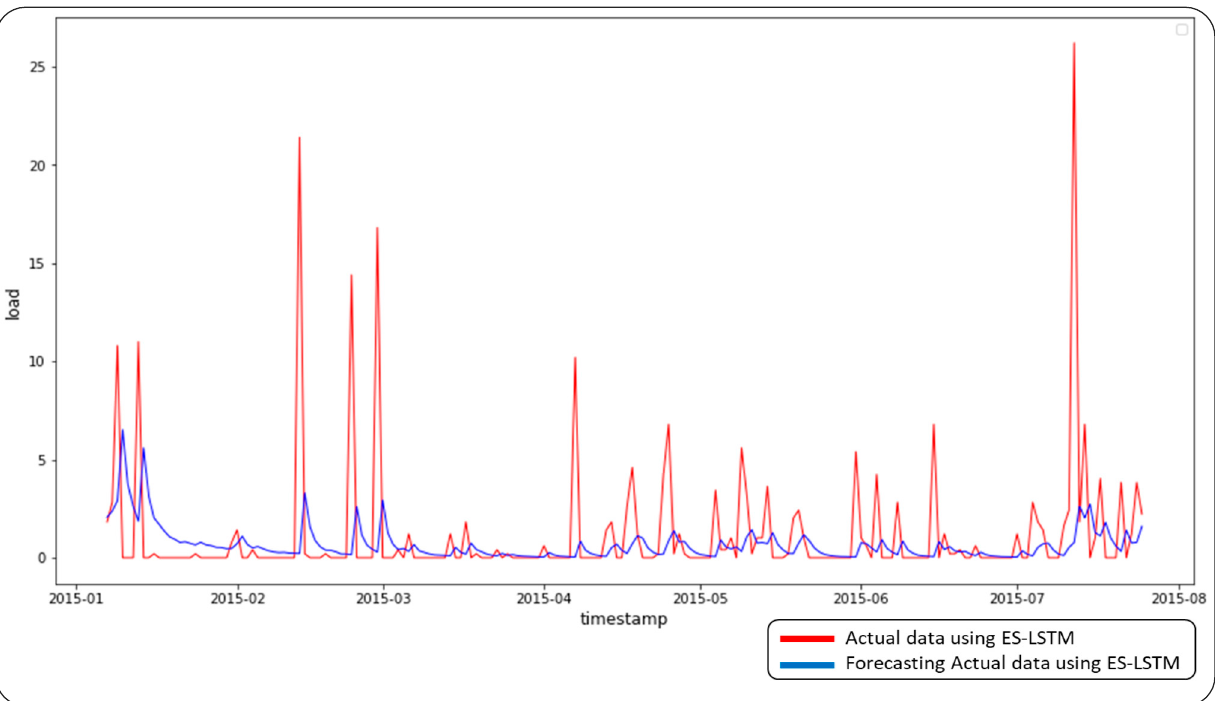
Figure 10. A comparison between actual and forecast data using ES-LSTM.